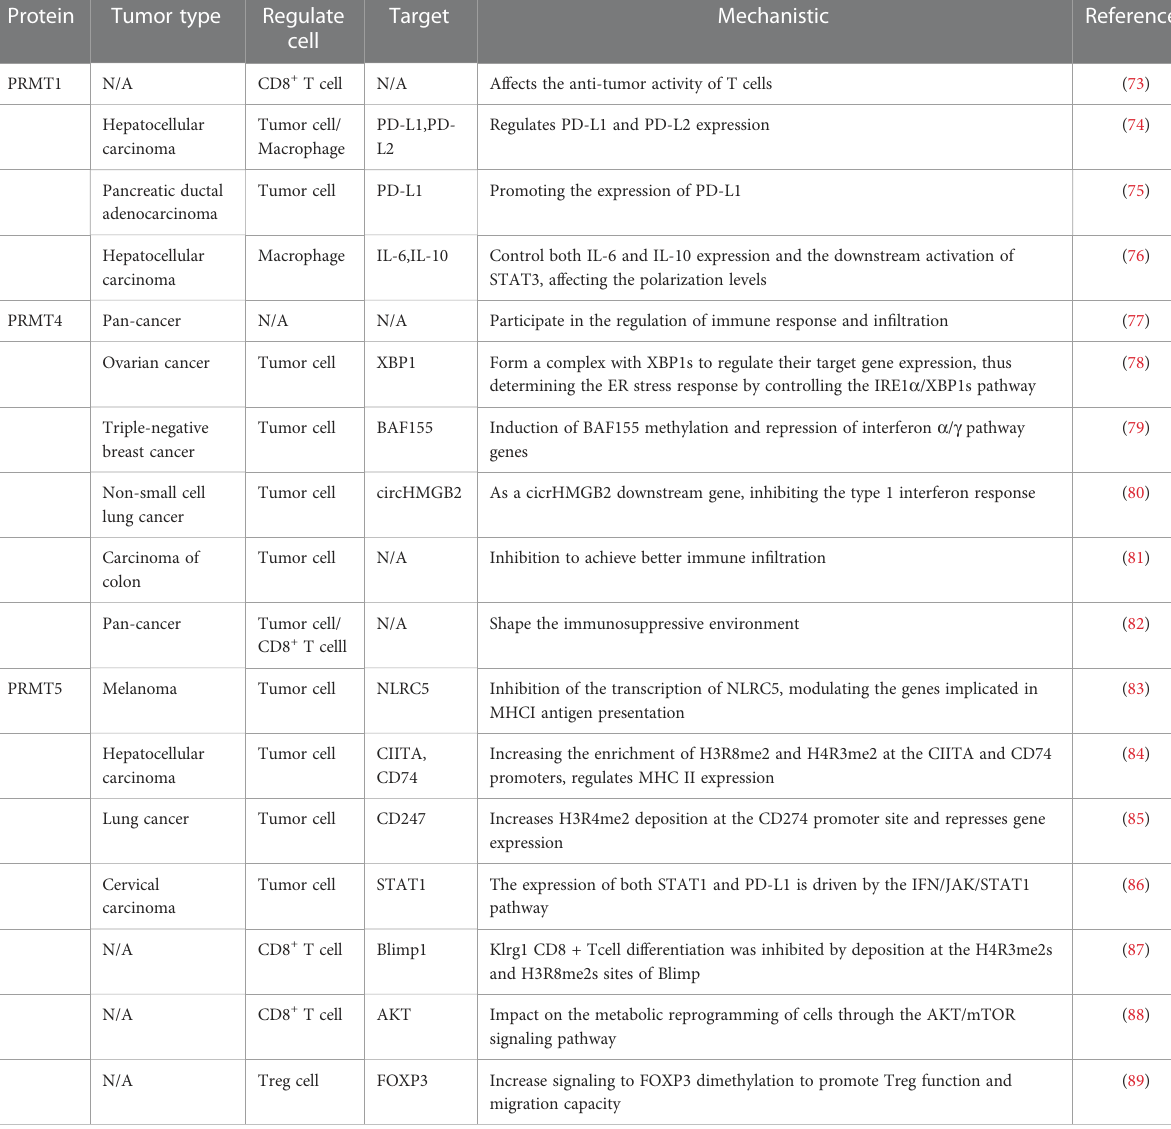
TABLE 2 Related functions of arginine methylase and tumor immunity.